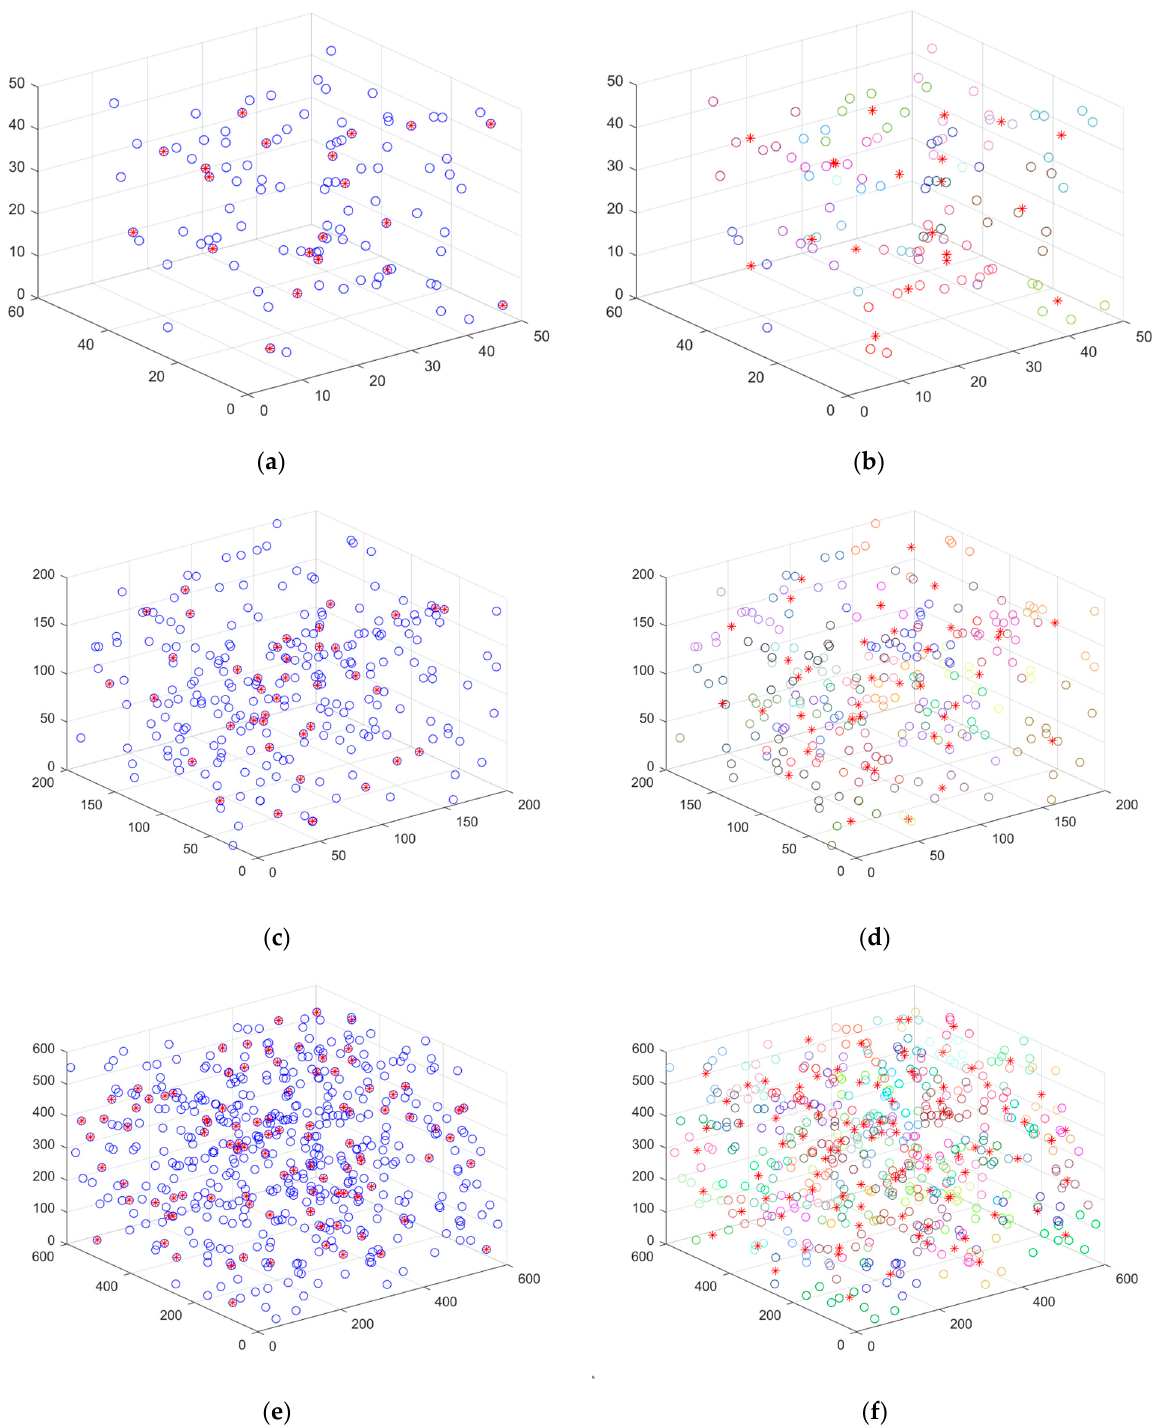
Figure 9. K-means clustering process: ( a ) The small networks: clustering raw data and the center of mass; ( b ) The small networks: K-means clustering results; ( c ) The medium-sized networks: clustering raw data and the center of mass; ( d ) The medium-sized networks: K-means clustering results; ( e ) The large networks: clustering raw data and the center of mass; ( f ) The large networks: K-means clustering results.